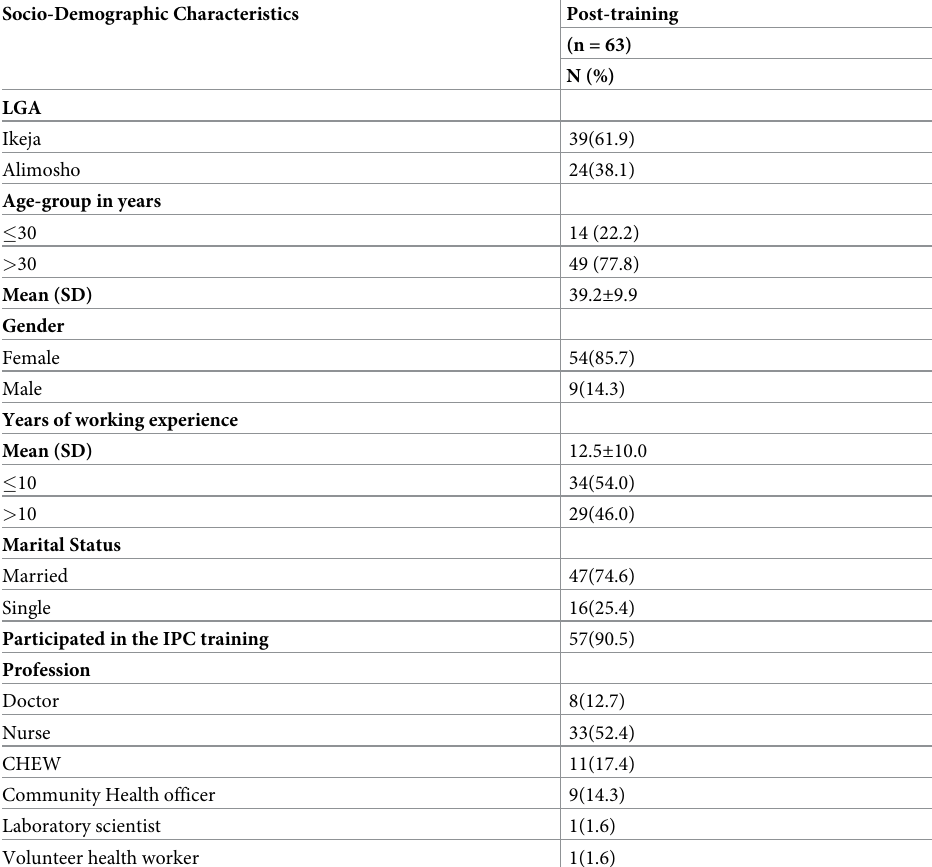
Table 1. Socio-demographic characteristics of PHC